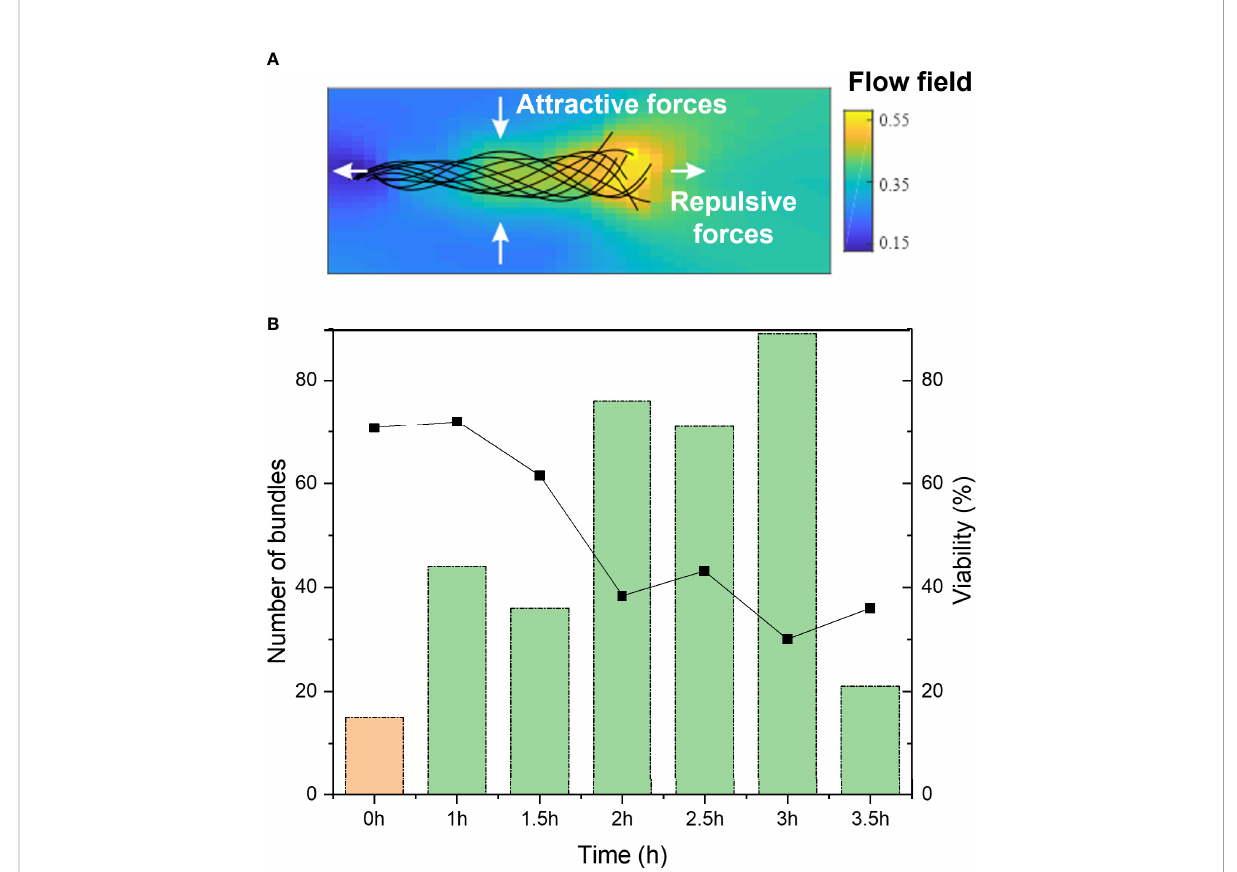
FIGURE 3 (A) Schematic of fl ow fi elds around a sperm cell, from head (left) to tail (right), displaying the attractive and repulsive forces. (B) Total number of cell bundles of bull sperm over post-thaw migration time. 0h shows before swim-up sperm at 0h time (orange), 1 to 3.5h refers to swim-up sperm (green). On the right y-axis is the overall viability plotted, obtained from fl uorescent staining at the different time